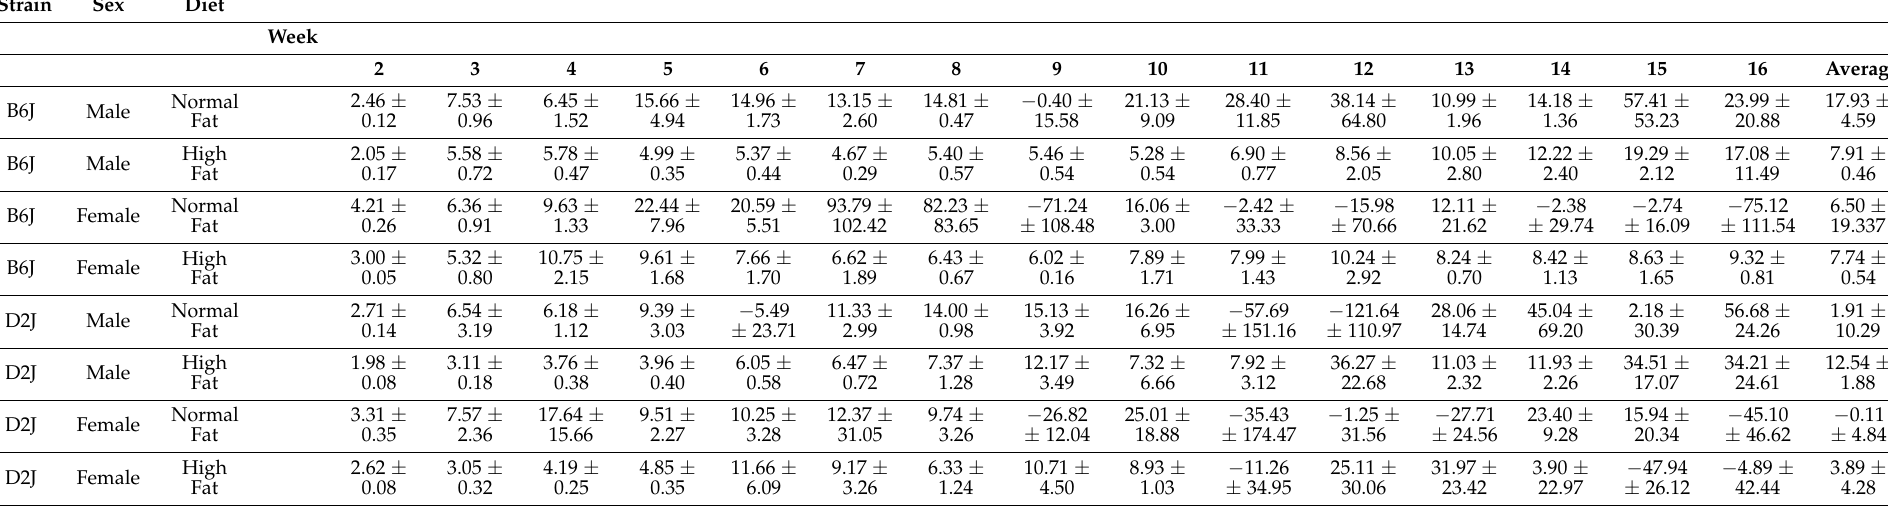
Table 1. Feed Efficiency Rate: Feed efficiency rate in kcal consumed per gram of weight gain per week. Feed efficiency rate was averaged for B6J male, B6J female, D2J male, and D2J female high-fat and normal-fat groups over the 16-week 60% kcal from fat high-fat diet or 10% kcal from fat normal-fat diet intervention. There were no significant differences between the average feed efficiency rate amongst NFD (6.559 ± 5.316 kcal/gm weight gained) and HFD (8.021 ± 1.367 kcal/gm weight gained) groups (t(12.449) = 0.266, p = 0.794), B6J (10.021 ± 4.461 kcal/gm weight gained) and D2J (4.560 ± 2.996 kcal/gm weight gained) strains (t(22) = 1.016, p = 0.321), and NFD and HFD groups for B6J males (t(4) = − 2.172, p = 0.096), B6J females (t(2.003) = − 0.064, p = 0.952), D2J males (t(2.134) = − 1.016, p = 0.205),